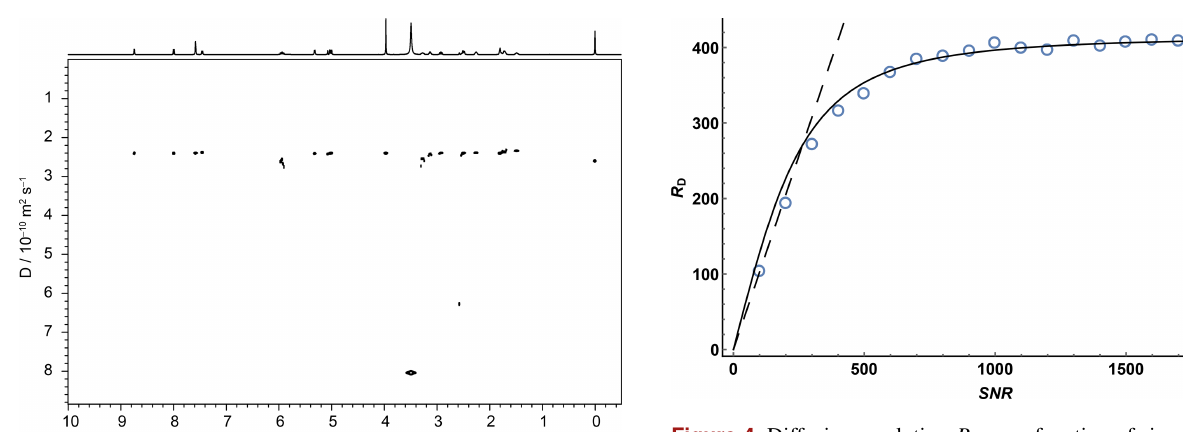
Figure 4. Diffusion resolution R D as a function of signal-to-noise ratio for the methoxy signal of quinine in a Oneshot experiment on a 100mM solution of quinine in DMSO-d 6 . Open circles show the average of 100 values of R D by fitting of the experimental data with the addition of synthetic Gaussian noise for each value of SNR, the dashed line shows the predicted Cramér–Rao limit, Eq. (11), for the experimental parameters used ( N = 12, (cid:15) max = 0 . 76), and the solid line the result of nonlinear least squares fitting of the Cramér–Rao limit modified to take into account the presence of other errors in the signal intensity, Eq. (12), with SNR lim =